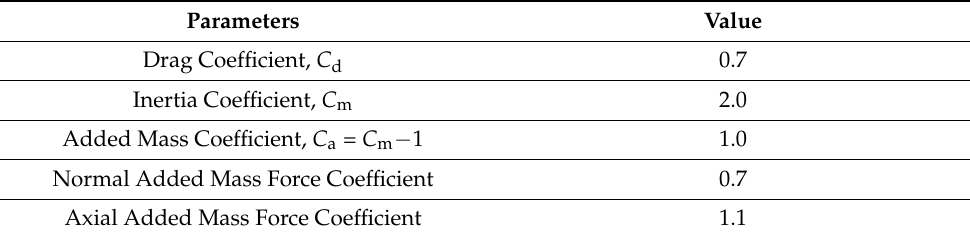
Table 10. Parameters for Hydrodynamic Coefficients.